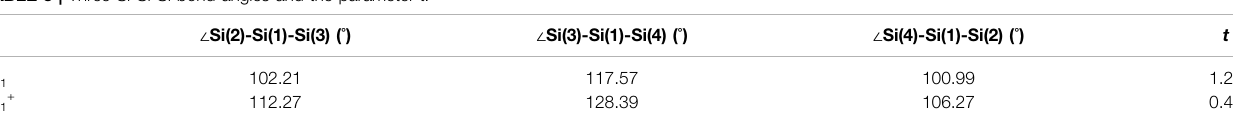
step of 1%. The stress-strain scatter diagrams are shown in Figure 5 . The external pressure is the equivalent pressure on the interface after stress is applied. A positive value indicates that the interface is compressed, and a negative value indicates that the interface is stretched. It is shown by the fi gure that the external pressure (or its absolute value) is almost linearly proportional to the strain degree.